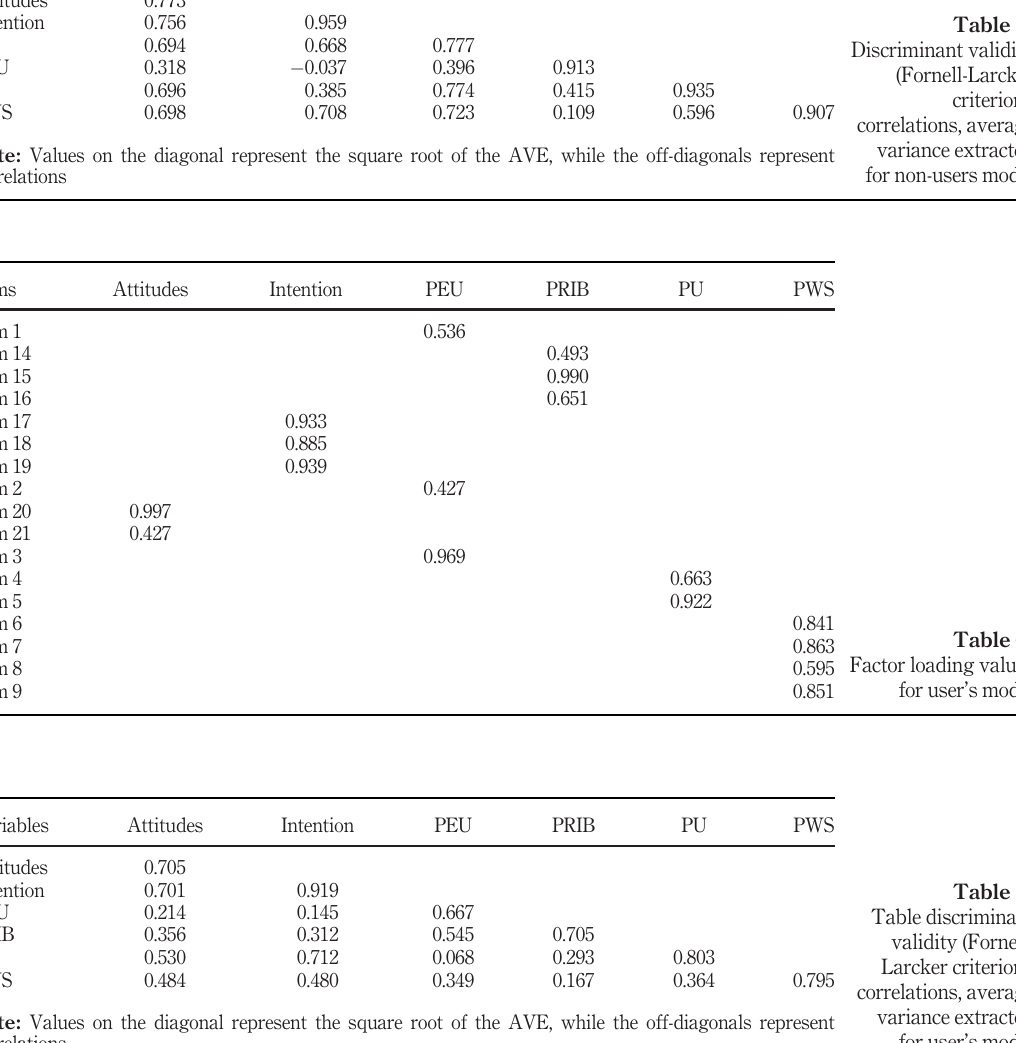
Table 5. Discriminant validity (Fornell-Larcker criterion),